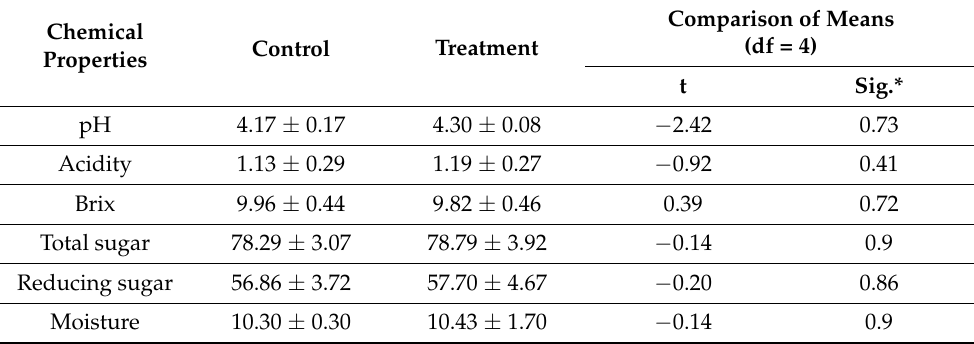
Table 4. Means ± standard errors of the chemical properties of the control and treated dried pieces of apricot after CO 2 gas treatment at the concentration of 33.4 mol%.